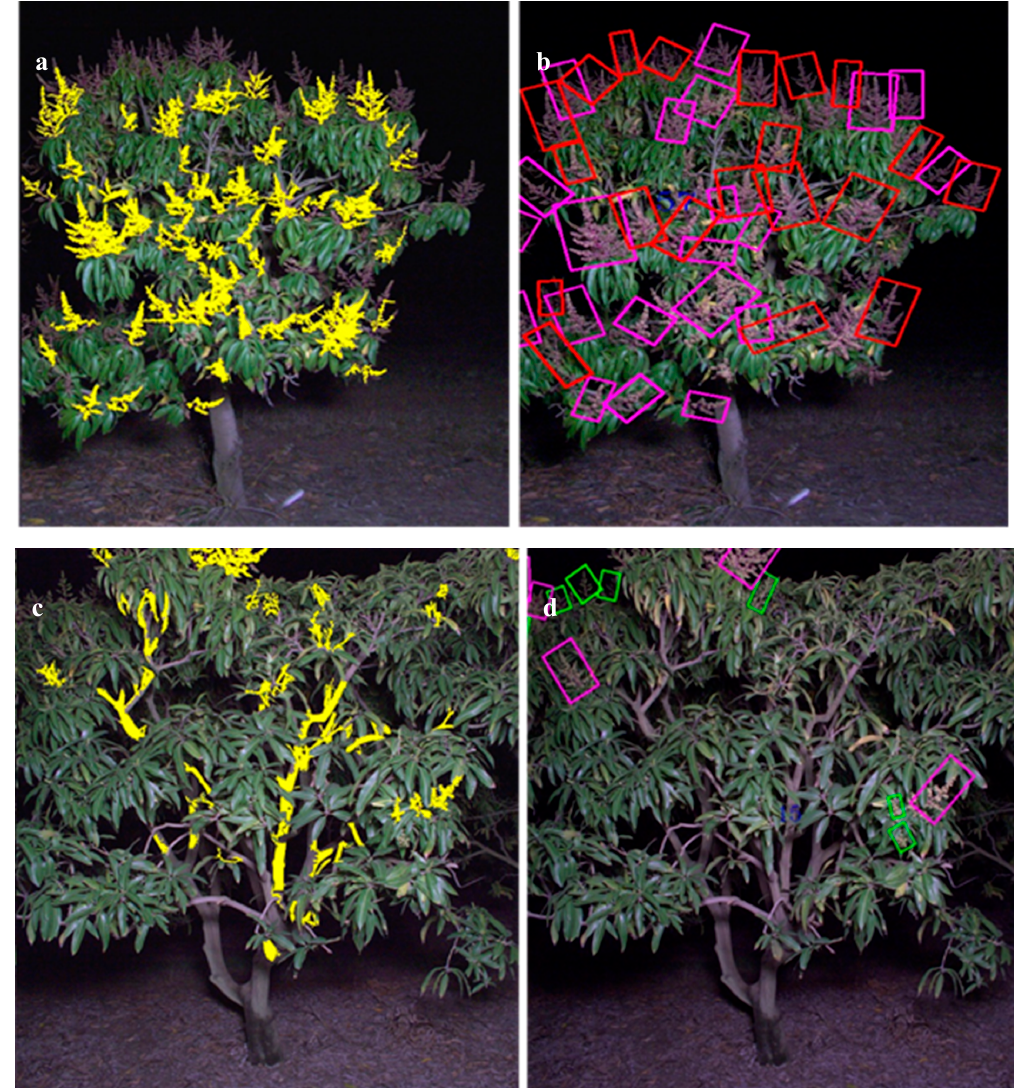
Figure 4. Pixel segmentation ( a , c ) and deep learning R 2 CNN(-rotated) ( b , d ) results for the same images. Flowers in the dark background did not segment properly ( a ), and branches and leaves were erroneously segmented as flower pixels (c).